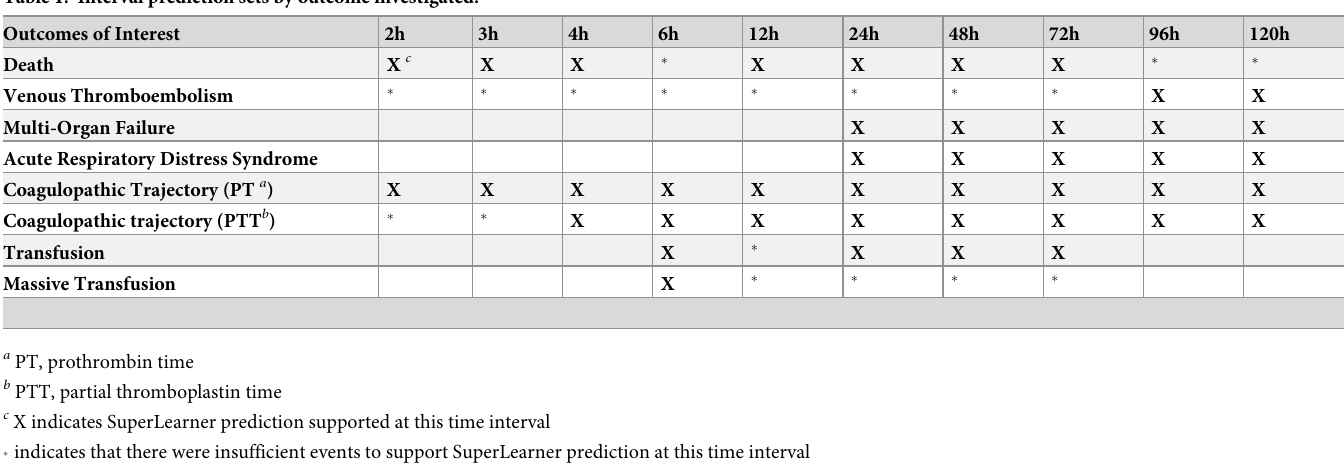
Table 1. Interval prediction sets by outcome